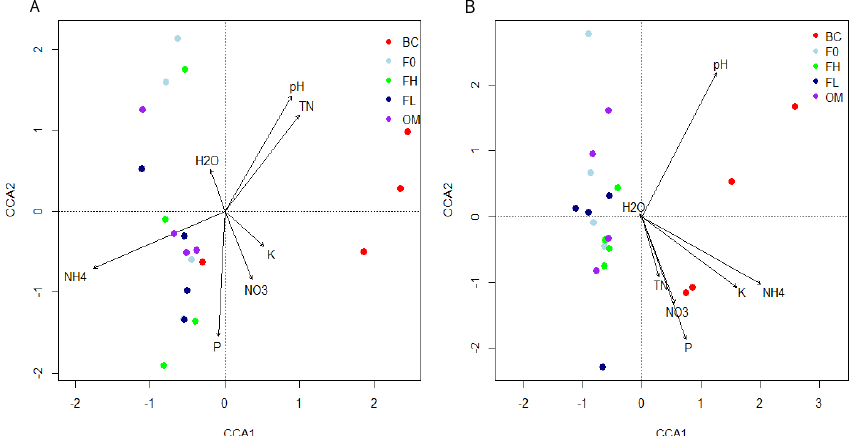
Figure 6. Canonical correspondence analysis (CCA) to show the correlation between the bacterial community structure and soil properties. ( A ) Bulk soil and ( B ) rhizosphere. Measured soil property factors include pH, water content (%), nitrate (NO 3 − ), ammonium (NH 4 + ) concentration (mg kg − 1 ), total nitrogen (mg g − 1 ), available phosphorus (mg kg − 1 ), and available potassium (mg kg − 1 ). Treatment: FO: no fertilizer, control; FL: low fertilizer; FH: